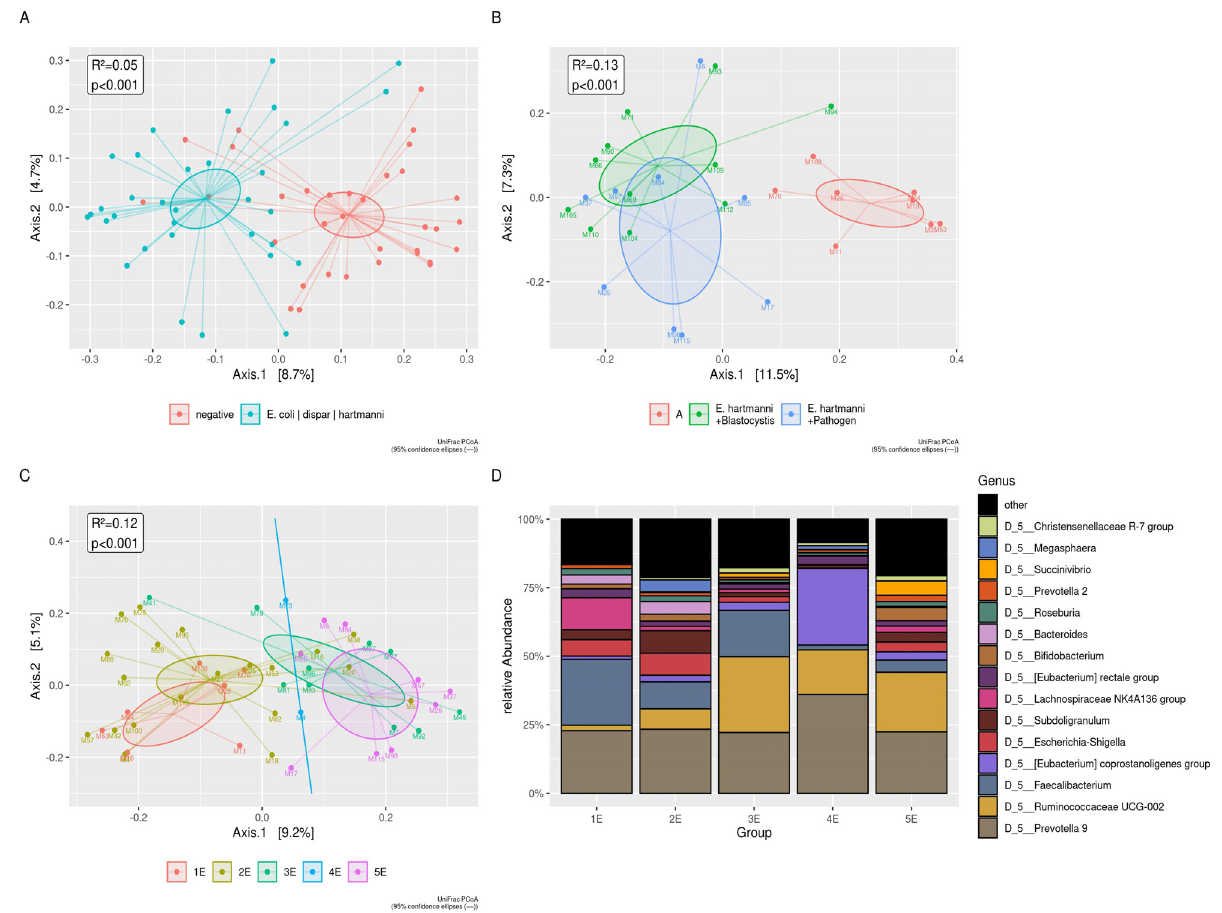
Figure 6. Beta diversity analysis in presence of Entamoeba spp. ( A ) The UniFrac distances between negative and positive subjects for Entamoeba spp., using principal coordinate analysis (PCoA) ( B ) The UniFrac distances among negative group, subjects harboring E. hartmanni and Blastocystis , and subjects harboring E. hartmanni, Blastocystis , and other pathogens, using principal coordinate analysis (PCoA). Group 1E: control group; Group: 2E: positive for pathogens not including Entamoeba spp.; Group 3E: subjects positive for En. coli and other pathogens; Group 4E: subjects positive for E. dispar and other pathogens; Group 5E: subjects positive for E. hartmanni and other pathogens. ( C ) The UniFrac distances among Group 1E, 2E, 3E, 4E, and 5E using principal coordinate analysis (PCoA). The groups carrying En. coli, E. dispar, and E. hartmanni (Groups 3E, 4E, and 5E) , clearly were separated from groups not harboring Entamoeba species (Groups 1E and 2E). ( D ) The plot of top 15 relative bacterial abundances at the genus level. All the significances relating to Figure 6A–D are summarized in Table S5D.